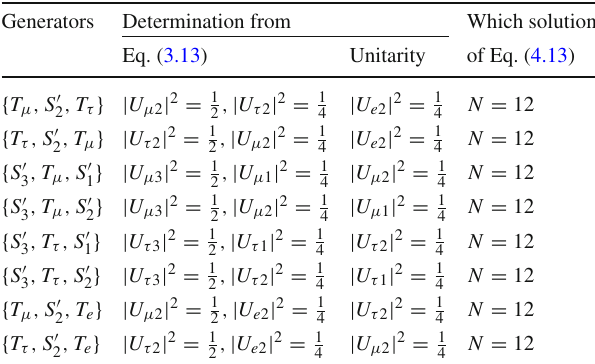
Table2 Allowedgeneratorsforthegroup B 3 (Note:ThisistheCoxeter nomenclature. The group has GAP identifier [ 48 , 48 ] and is isomorphic to A 3 × Z 2 or S 4 × Z 2 [43].) Generators Determination from Which solution Eq. (3.13) Unitarity of Eq. (4.13)